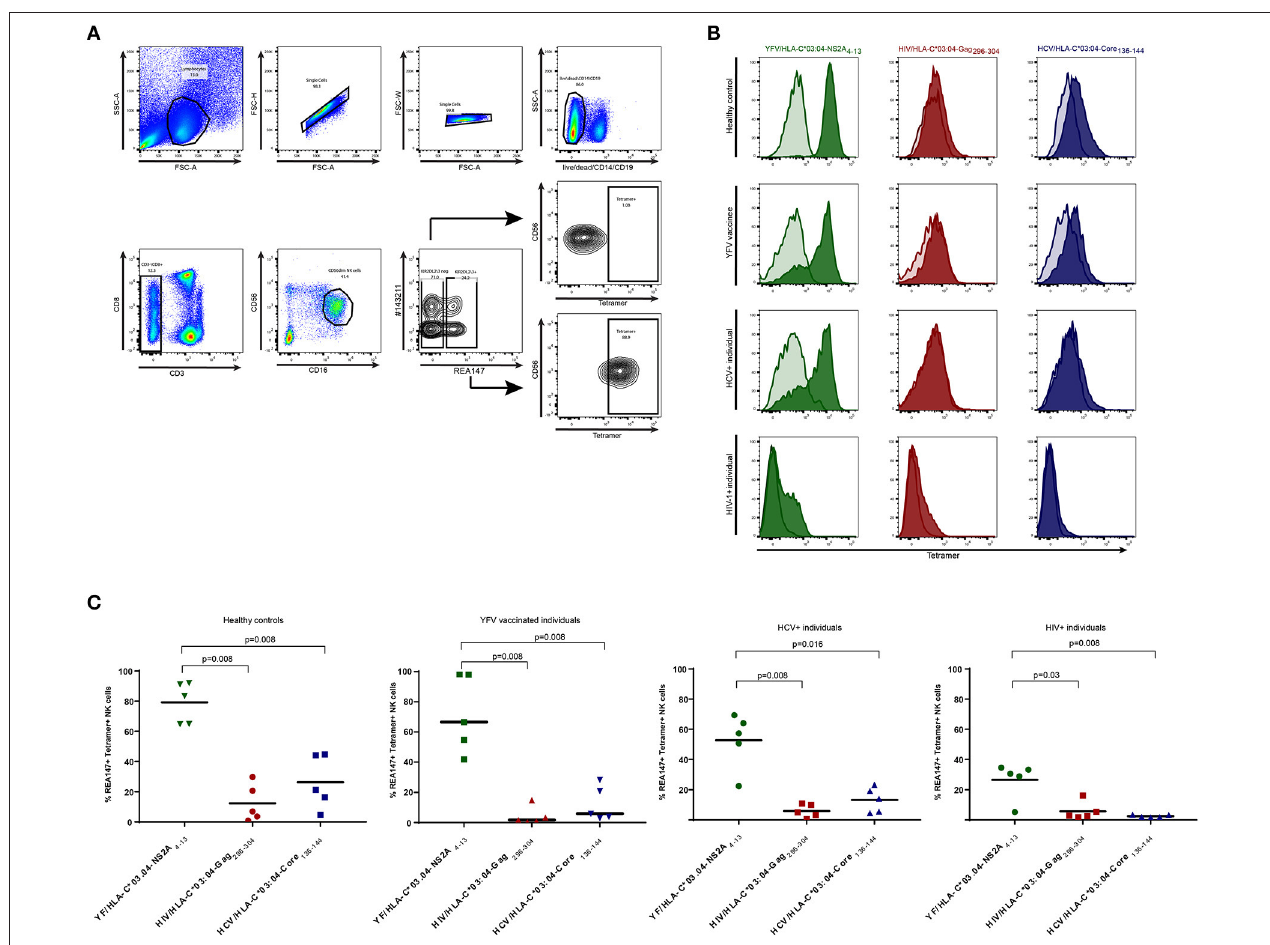
FIGURE 1 | Frequencies of tetramer + KIR2DL2/3 + NK cells in YFV vaccine-recipients, HIV-1-infected individuals, HCV-infected individuals and healthy controls. Staining of NK cells with YFV/HLA-C*03:04-NS2A 4 − 13 -, HIV/HLA-C*03:04-Gag 296 − 304 - and HCV/HLA-C*03:04-Core 136 − 144 -tetramers is depicted in green, red and blue respectively. (A) Gating strategy used to identify KIR2DL2/3 + (clone REA147 + ) and KIR2DL2/3 neg (clone REA147 neg ) NK cells. (B) Histograms demonstrating representative tetramer-staining of KIR2DL2/3 + NK cells (tinted) and KIR2DL2/3 neg NK cells (transparent) of healthy control subject, YFV vaccine recipient, HCV-infected individual and HIV-1-infected individual. (C) Scatter Plots of frequencies of tetramer + KIR2DL2/3 + (clone REA147 + ) NK cells in all study groups. Black bar represents median of each group. Freshly isolated PBMCs were used for all study groups except HIV-1-infected individuals, for which cryopreserved PBMCs were used. P -values were calculated using Mann-Whitney